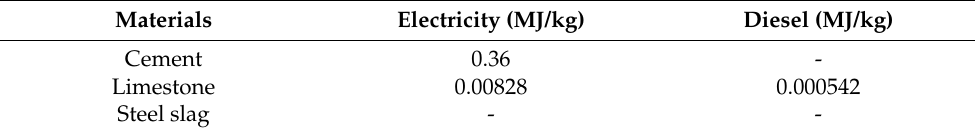
Figure 9. Virtual process for the cement-stabilized aggregate mix preparation. Table 4. Energy consumptions for unit material production [19].